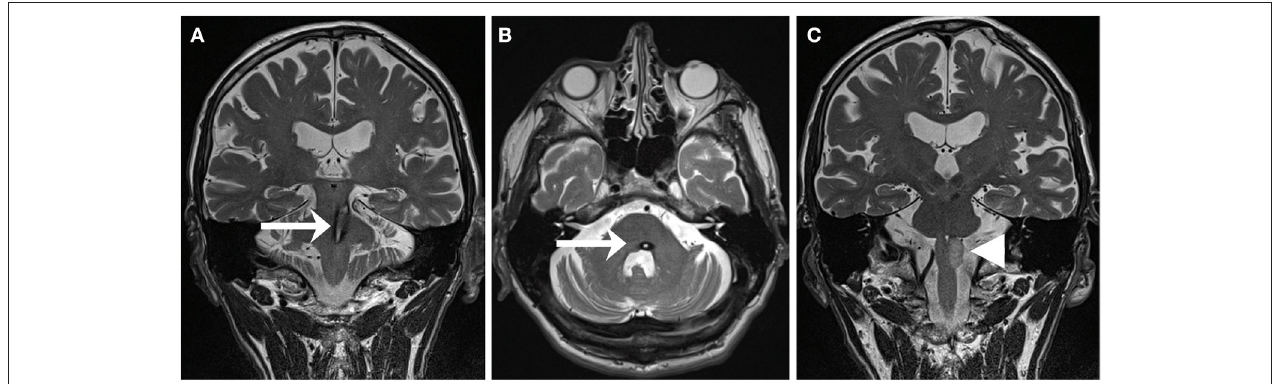
FIGURE 2 | T2-weighted MRI of a 59-year-old patient suffering from pontine-mesencephalic bleeding (A,B) affecting the central tegmental tract on the left (arrows). Within 13 months, the patient developed a HOD (C) with hyperintensity of the left olive (arrowhead) accompanied by the clinical syndrome of a palatal tremor, a pendular nystagmus, and a Holmes tremor [adapted with permission from Foerch et al.